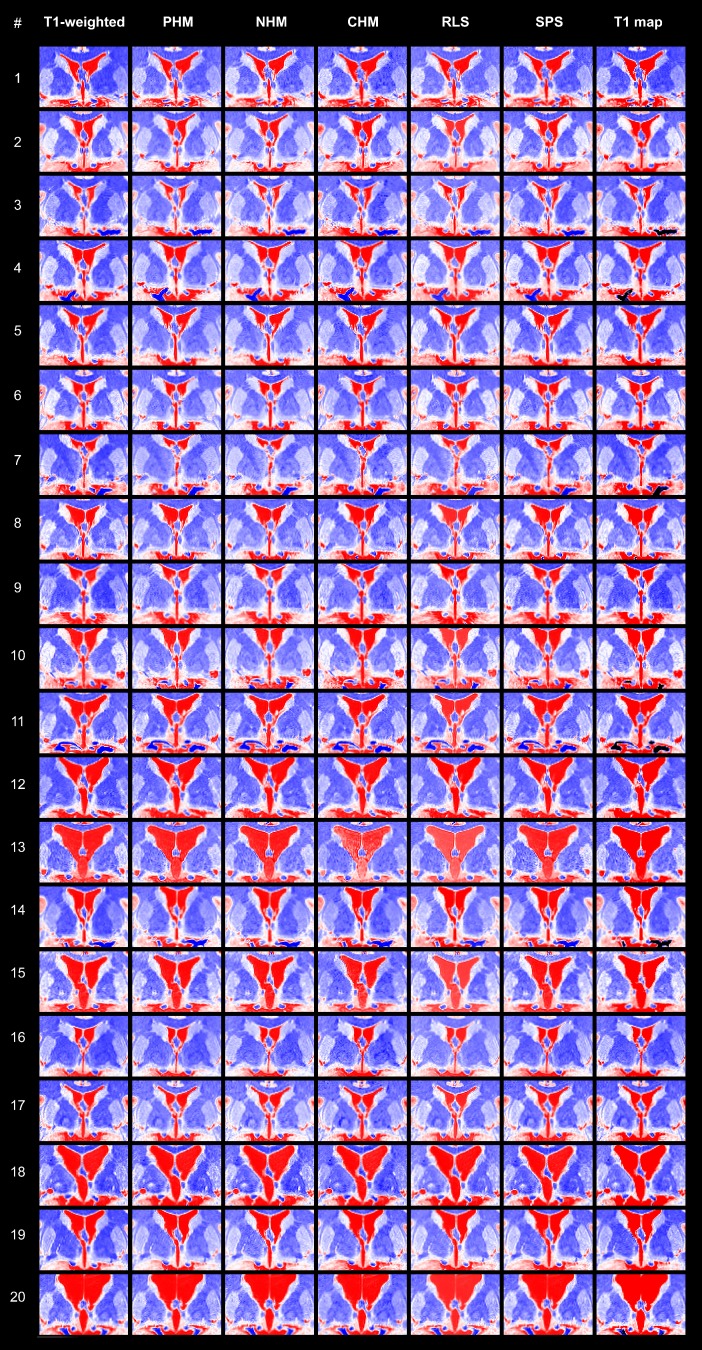
Inter-individual intensity variation revealed by colour-coding.Coronal view of all target images—the two MP2RAGE contrasts (column 1 and 7) and the intensity standardisation results (columns 2–6). Compare, e.g. #9 with overexposed GM and WM, and #10 with relatively dark GM and WM. CHM cumulative histogram matching, NHM non-linear histogram matching, PHM piecewise linear histogram matching, RLS ROI-based linear standardisation, SPS segmentation-based piecewise linear standardisation.